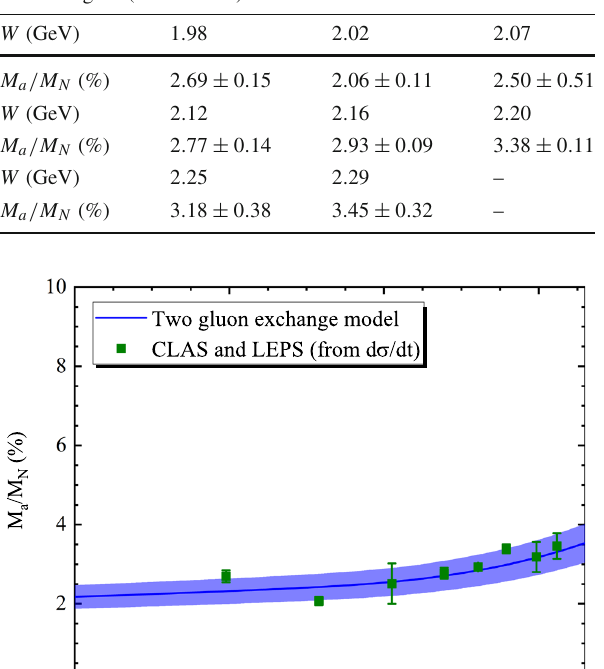
Table 3 The trace anomaly contribution M a / M N based on the d σ/ dt | t = t of meson φ from the CLAS [23] and LEPS data [22]. thr The average is (2 . 90 ± 0 . 23)%